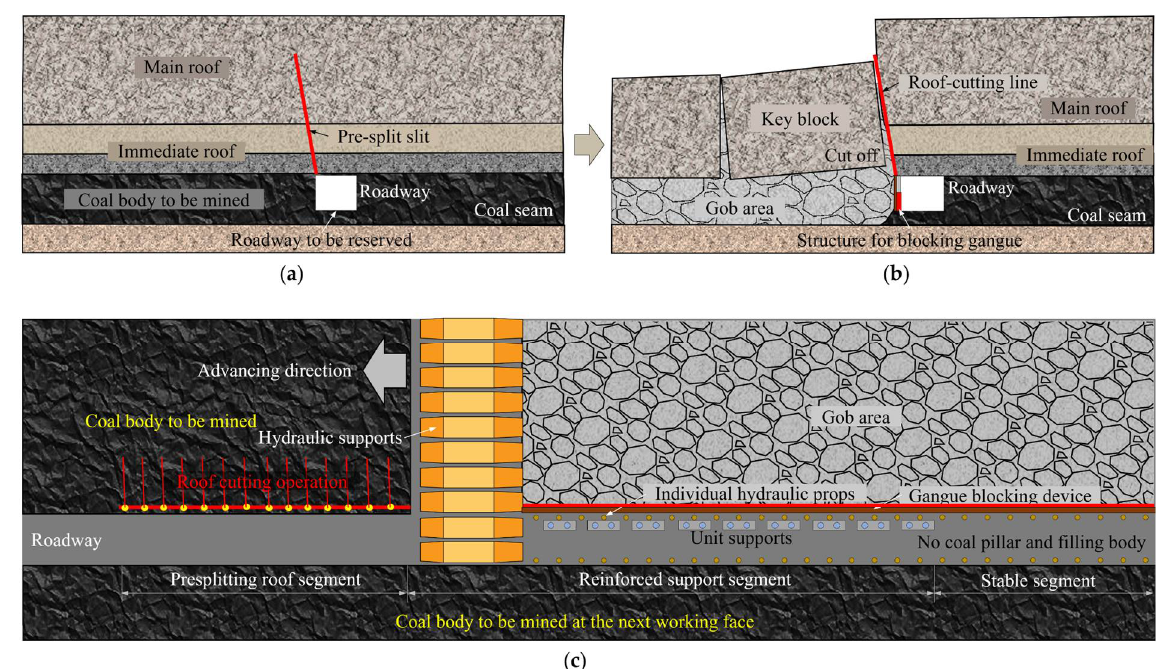
Figure 12. Gob-side entry retaining technology without coal pillar and filling body. ( a ) Pre-splitting roof in advance of the working face ( b ) Cutting roof to form roadway automatically ( c ) Working methods of roof cutting in advance and gob-side entry retaining with no-pillar.